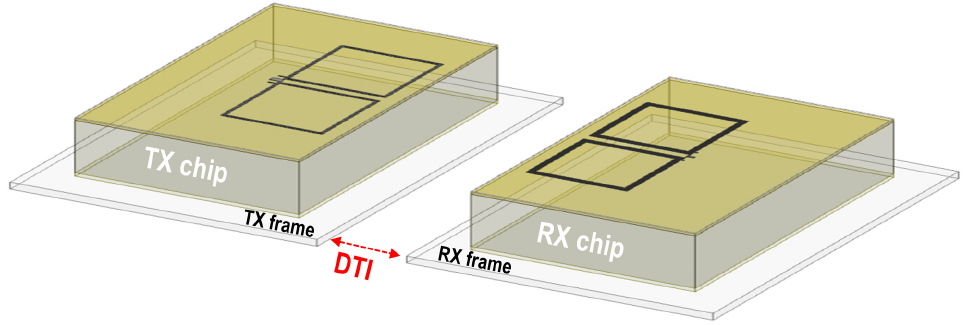
Figure 12. 3D EM simulation view of TX and RX micro-antennas for a package-scale galvanic isola-